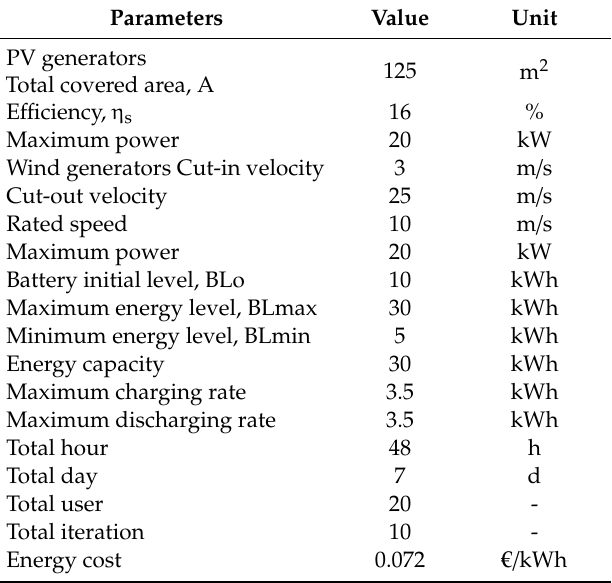
Table 1. Simulation parameters